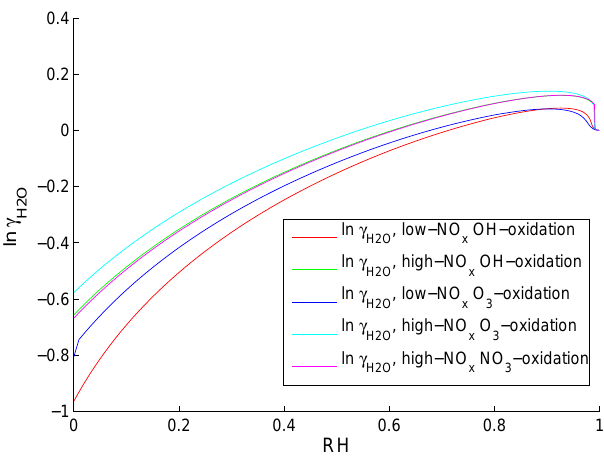
Fig. 13. The activity coefficient of water in function of RH, for the five oxidation scenarios (at